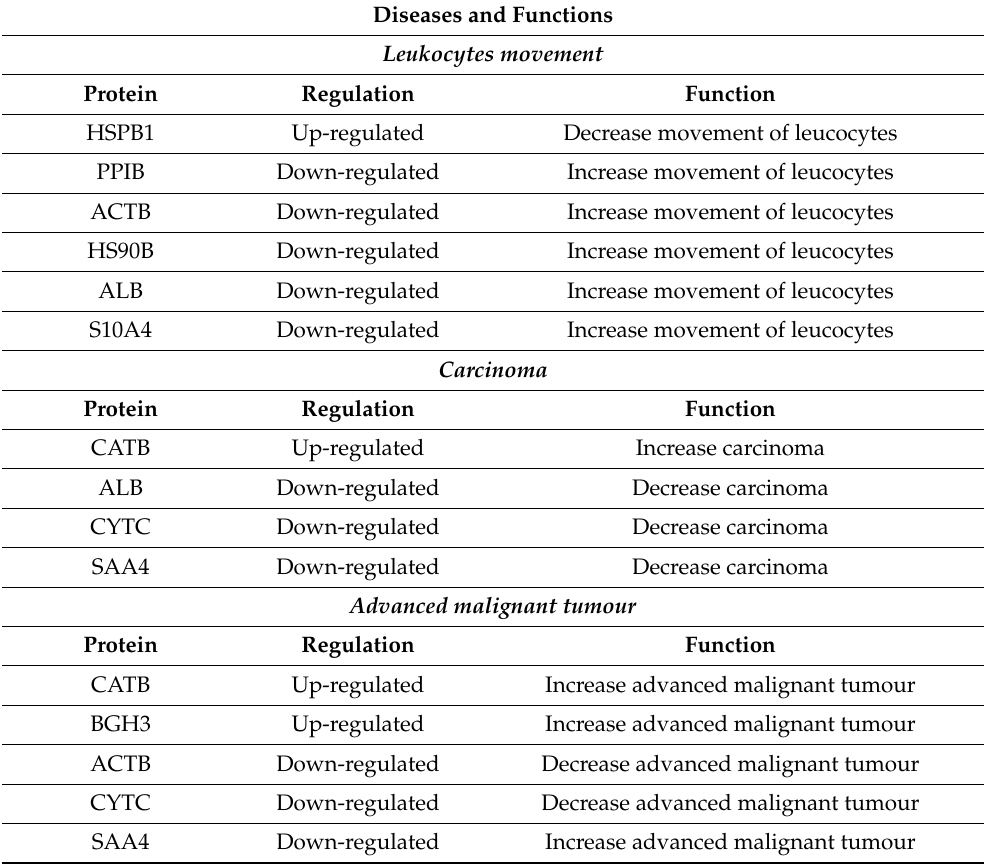
Table 2. Diseases and functions analysis. Leukocytes movement, carcinoma and advanced malignant tumor resulted the most significant diseases and functions classes associated with modulated proteins. The proteins with their function and regulation after p53 knock-down are reported in the